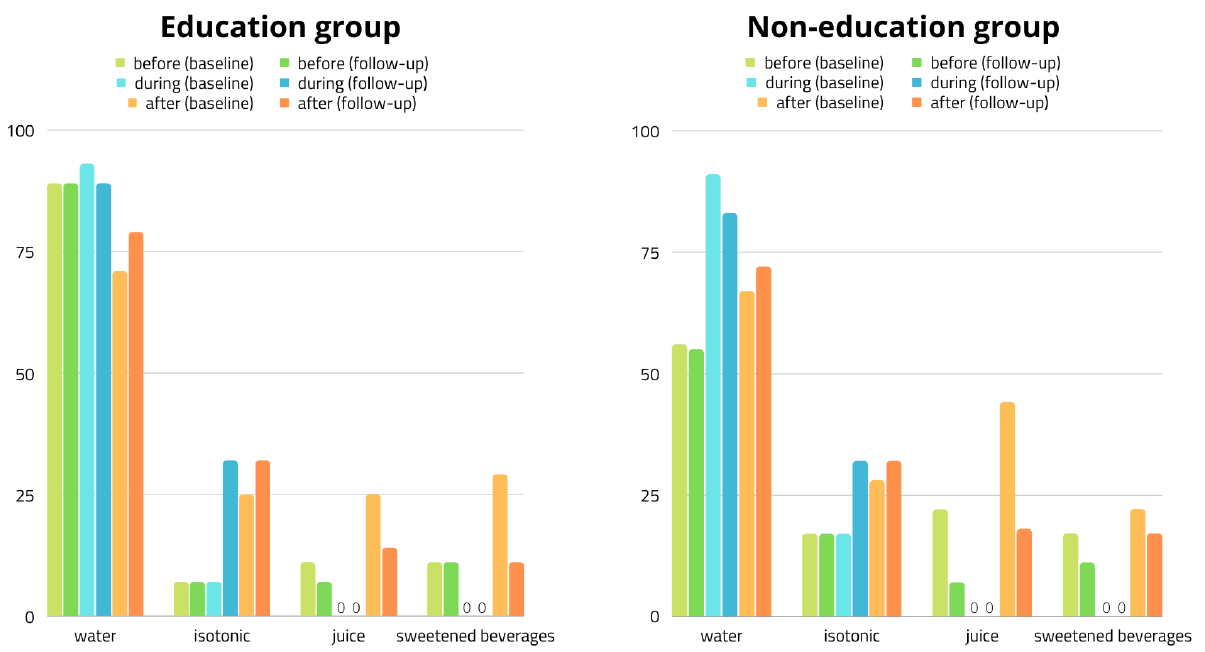
Figure 4. Percentage of participants ’ choices of peri-exercise fluid throughout the study.